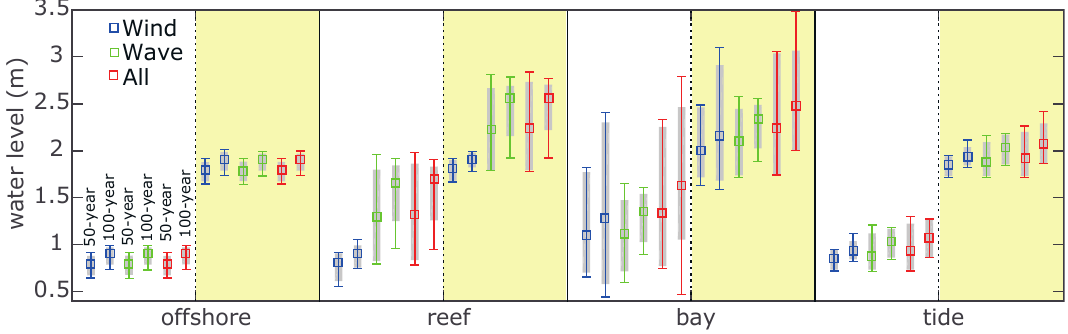
Figure 8. Distribution of maximum water levels amongst 50-year and 100-year RI ensemble members at “offshore”, “reef”, “bay”, and “tide” locations (see Figure 5). Blue, green, and red indicate wind, wave, and all forcing, respectively (as indicated at upper left); median ensemble values are indicated with a square; 5th and 95th percentile values are indicated with grey bars, respectively, and ensemble minima and maxima by colored error bars. At each location indicated, the “baseline” scenario is on the left (white background) and the “SLR” scenario is on the right (yellow